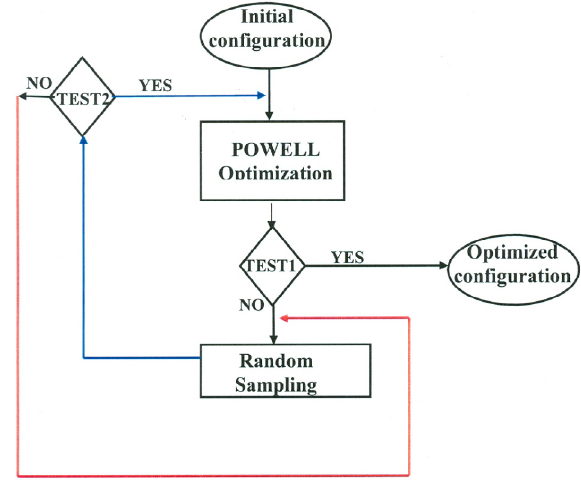
Fig. 11. Heuristic optimization algorithm: Powell optimization embedded within a simple random optimization